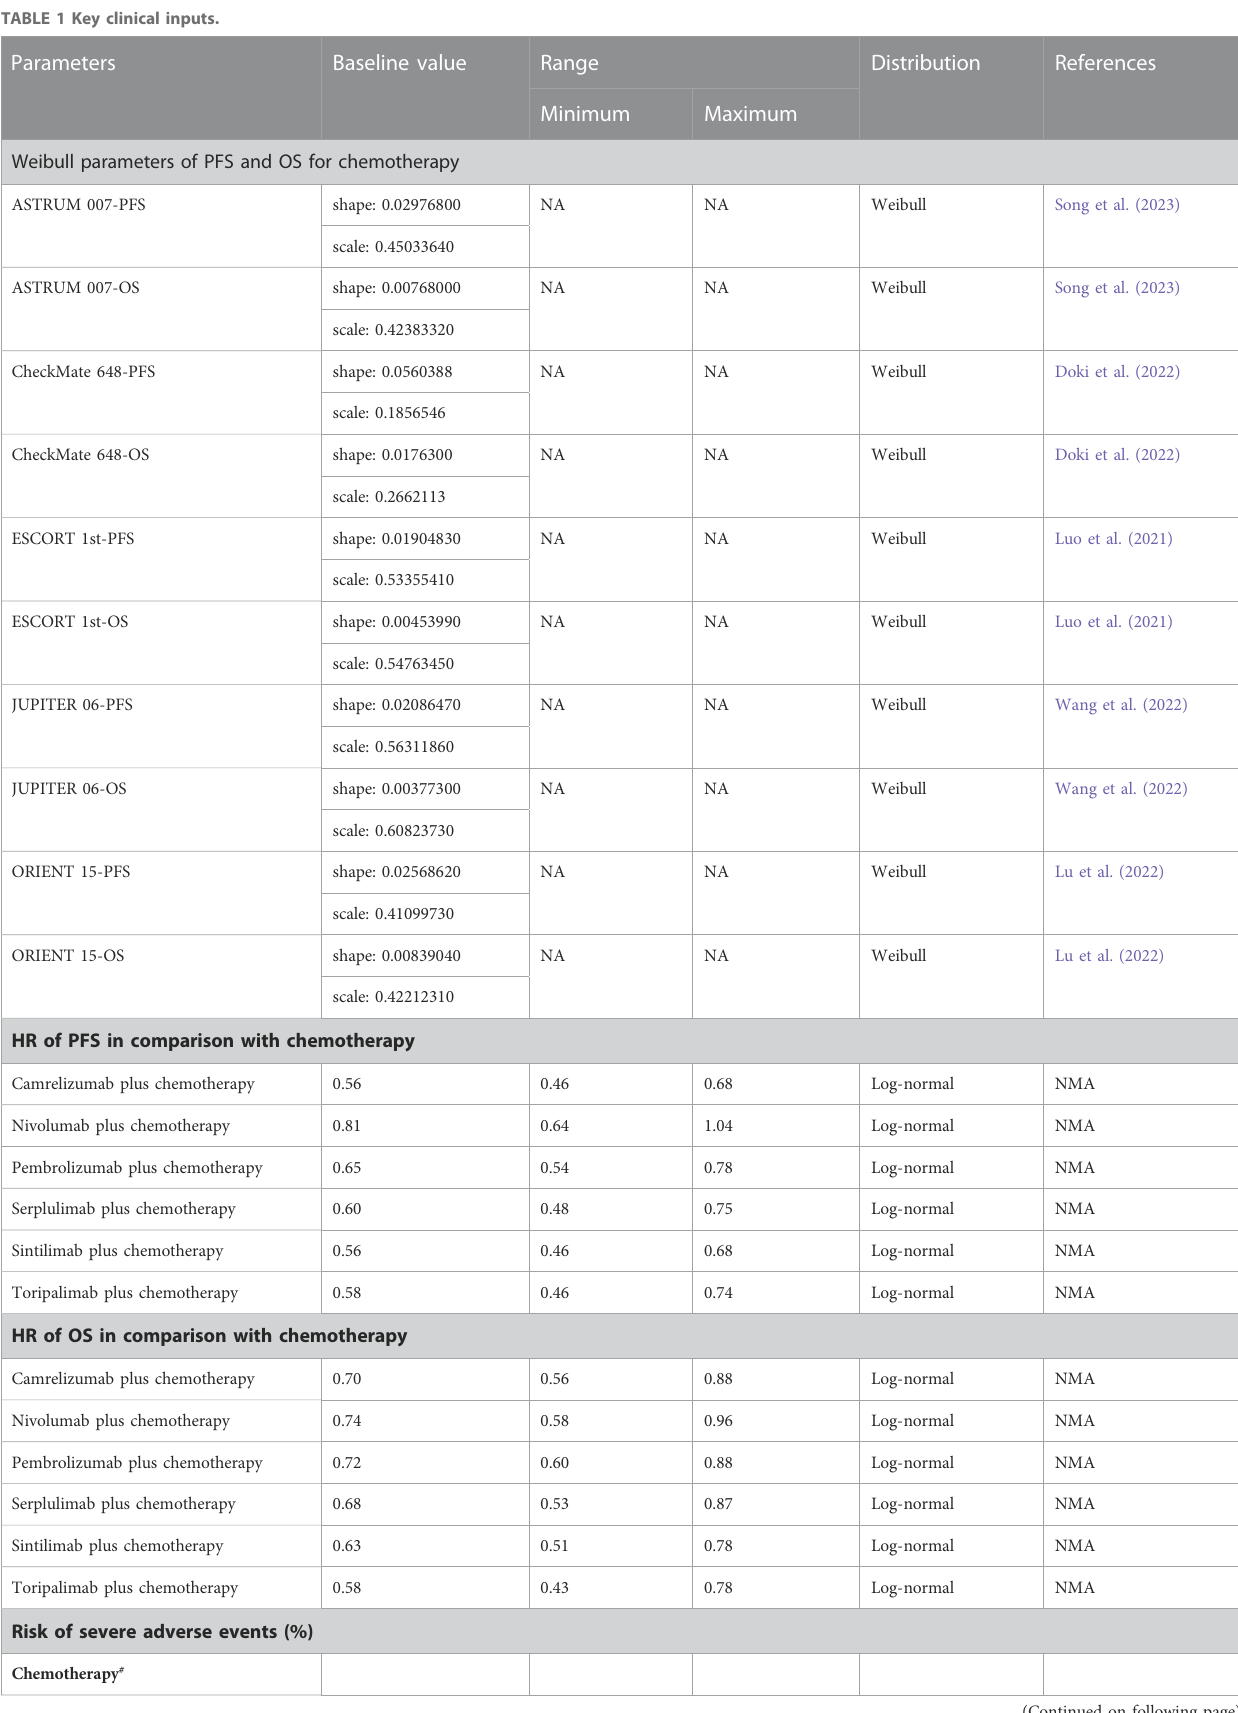
TABLE 1 Key clinical